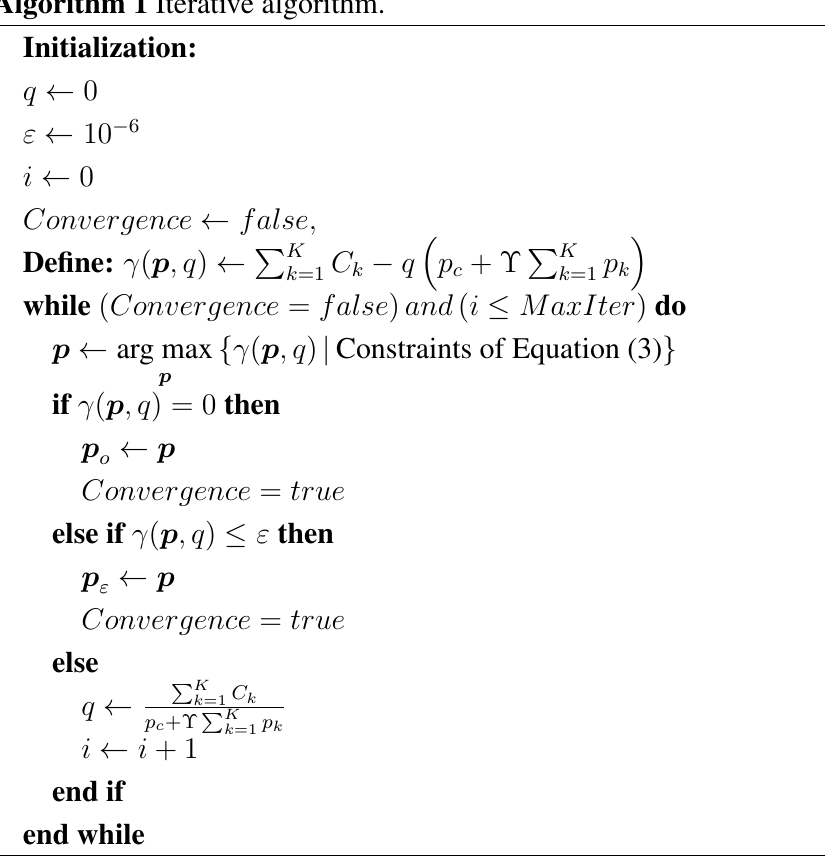
Algorithm 1 Iterative